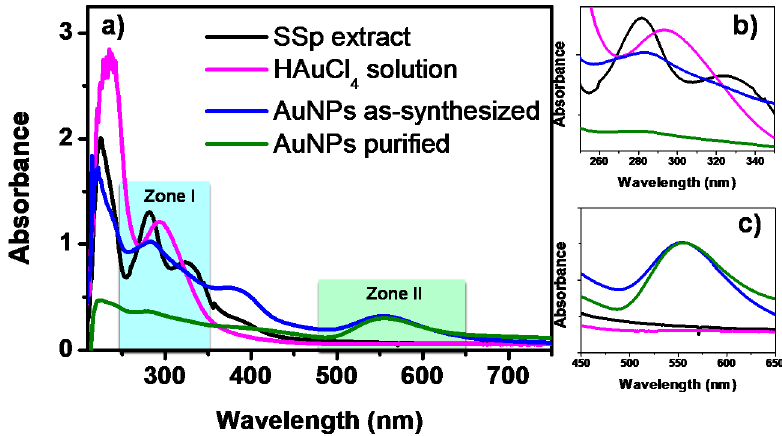
Figure 3. ( a ) UV-Vis analysis of the precursor salt, Ssp extract, and AuNPs before and after the purification process. ( b , c ) UV-Vis spectra of the zones I and II obtained from the Figure 3a.